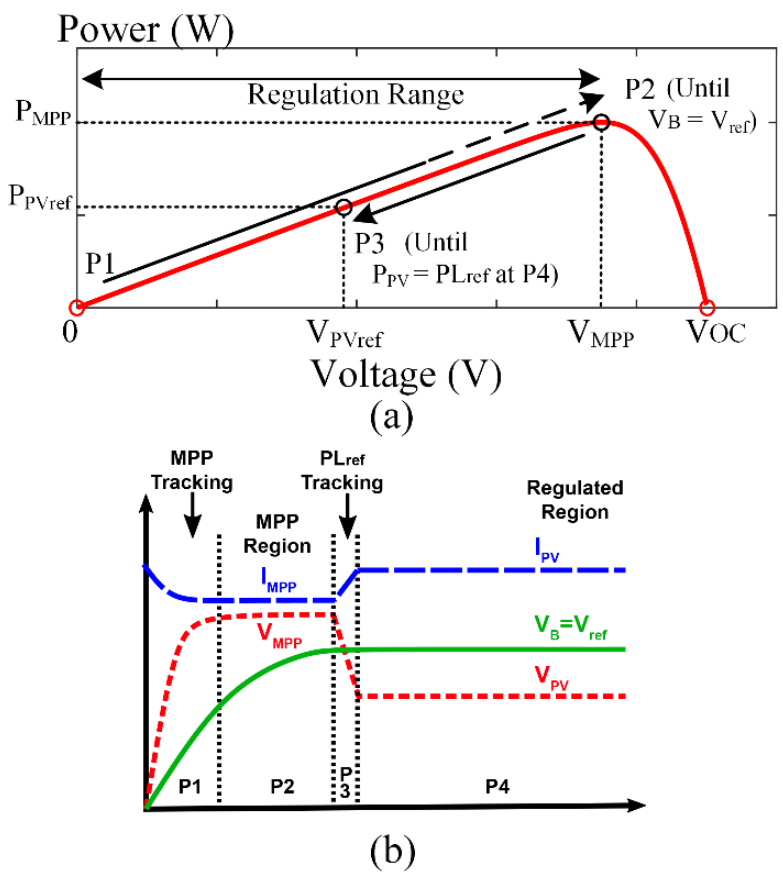
Figure 5. POVC tracking operation and regulating range representation using ( a ) P-V curve. ( b ) Input and output characteristics.